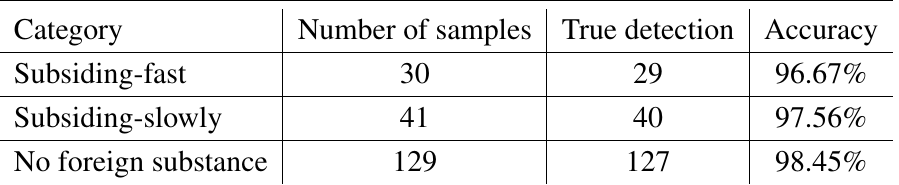
Table 2. Detection result of 200 samples.